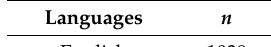
Table 2. Scientific languages of publications.